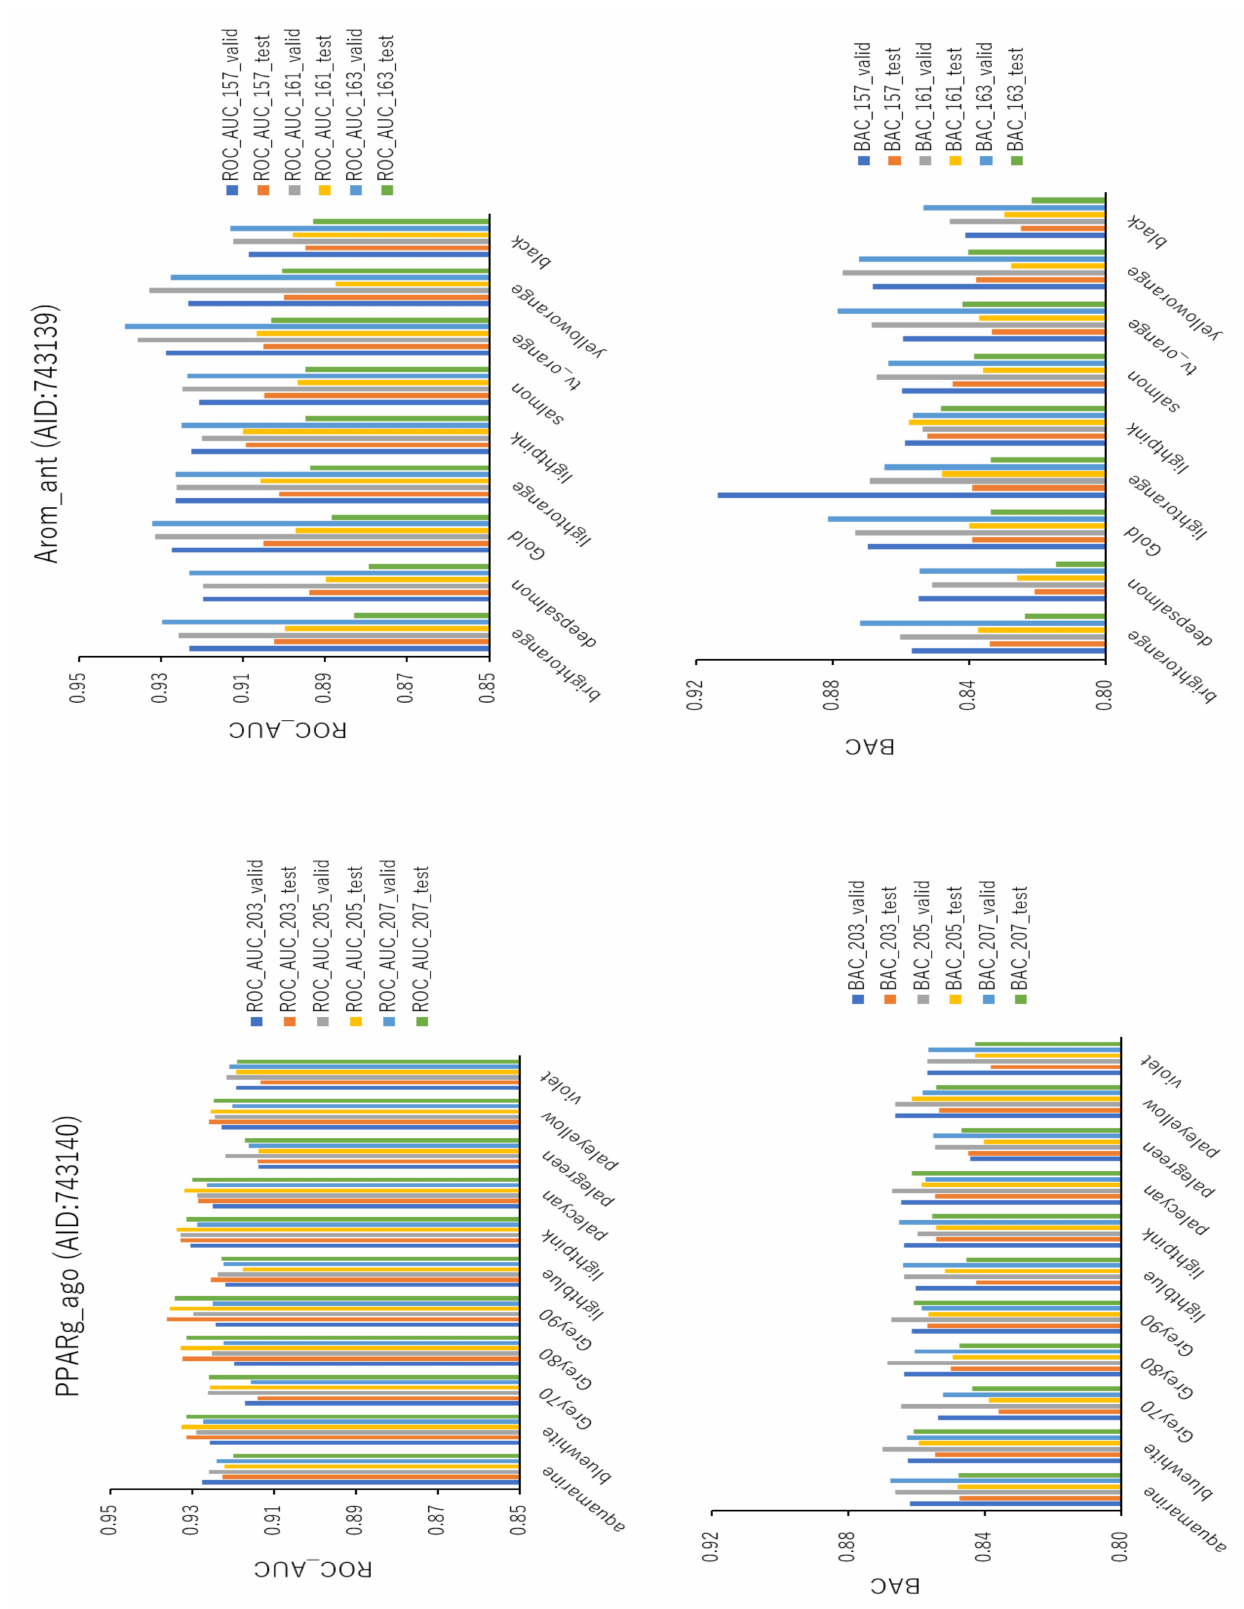
Figure 13. ROC_AUC and BAC for PPARg_ago (AID:743140) and Arom_ant (AID:743139) using TensorFlow with different background colors. Three-fold experiments were